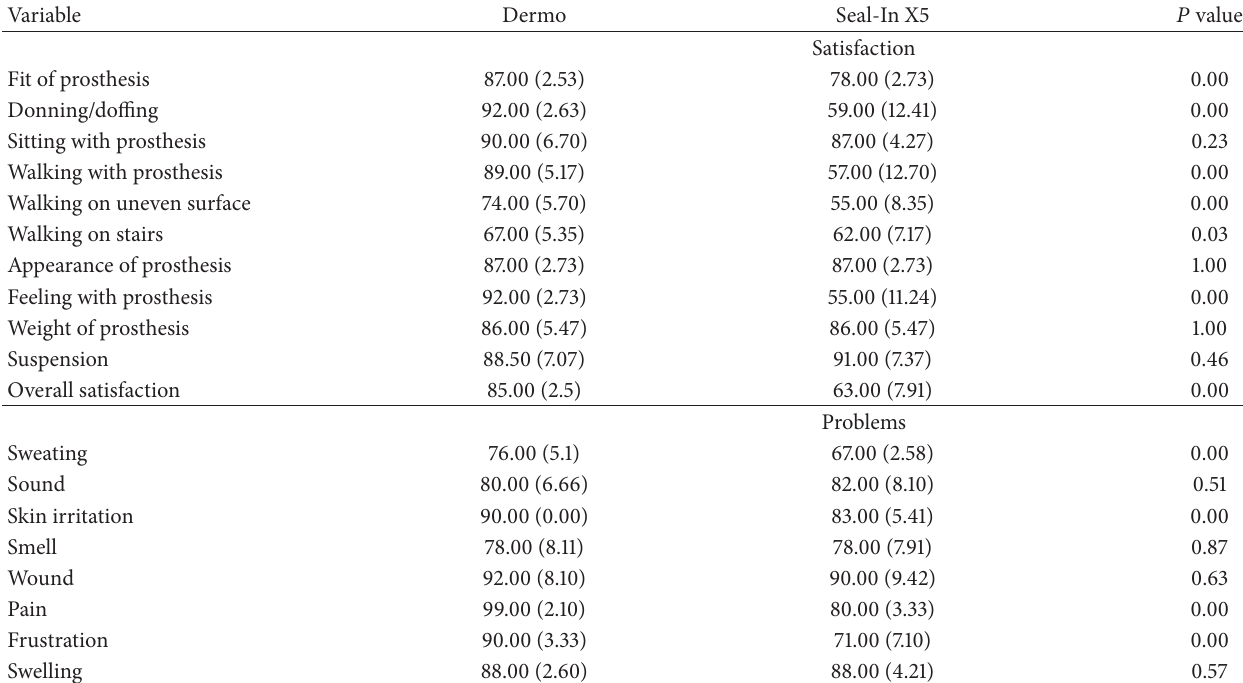
Table 3: Comparison between Dermo and Seal-In X5